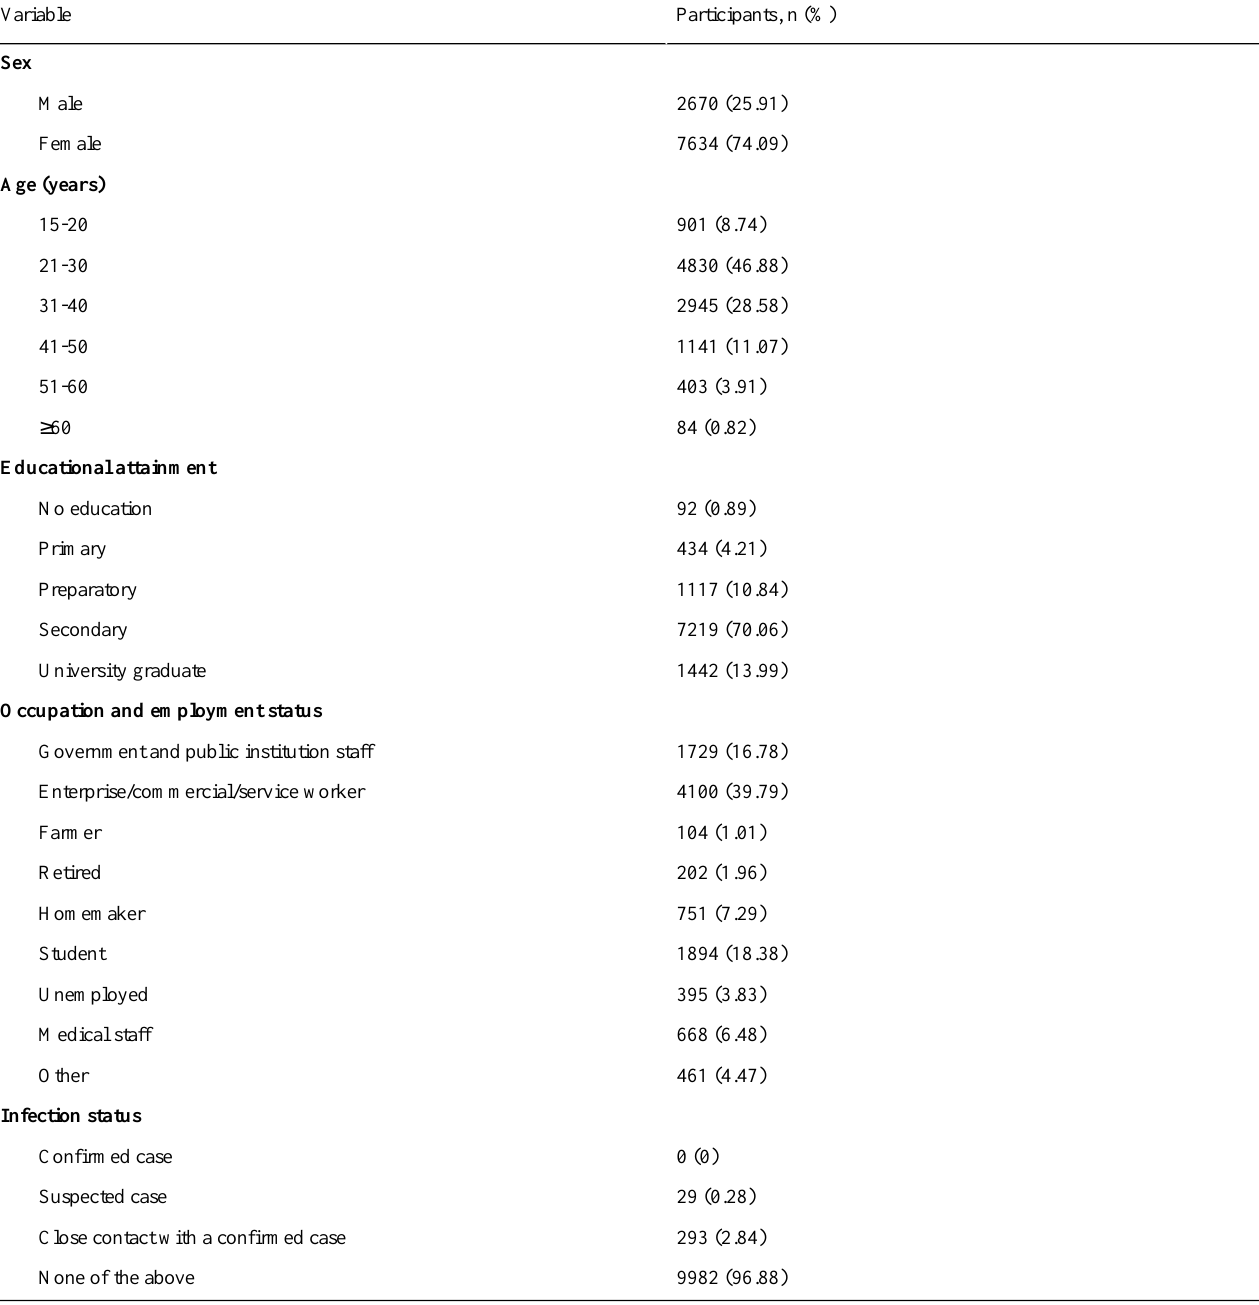
Table 1. Participants’sociodemographic characteristics